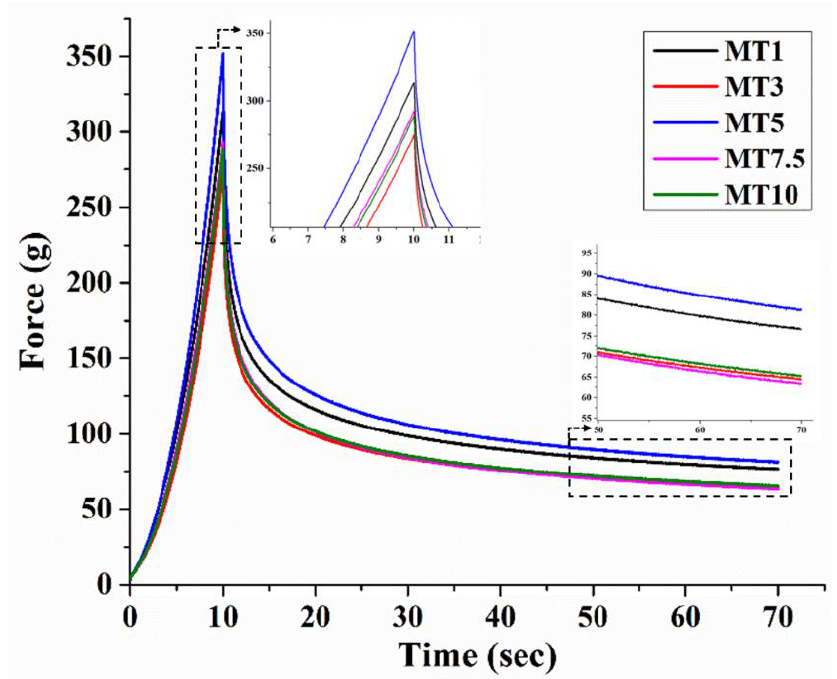
Figure 10. Stress relaxation profile of cookie